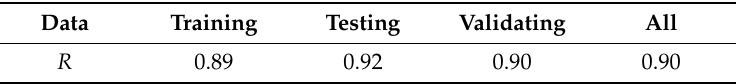
Table 2. Certificates of the first ANN model for the whole dataset.